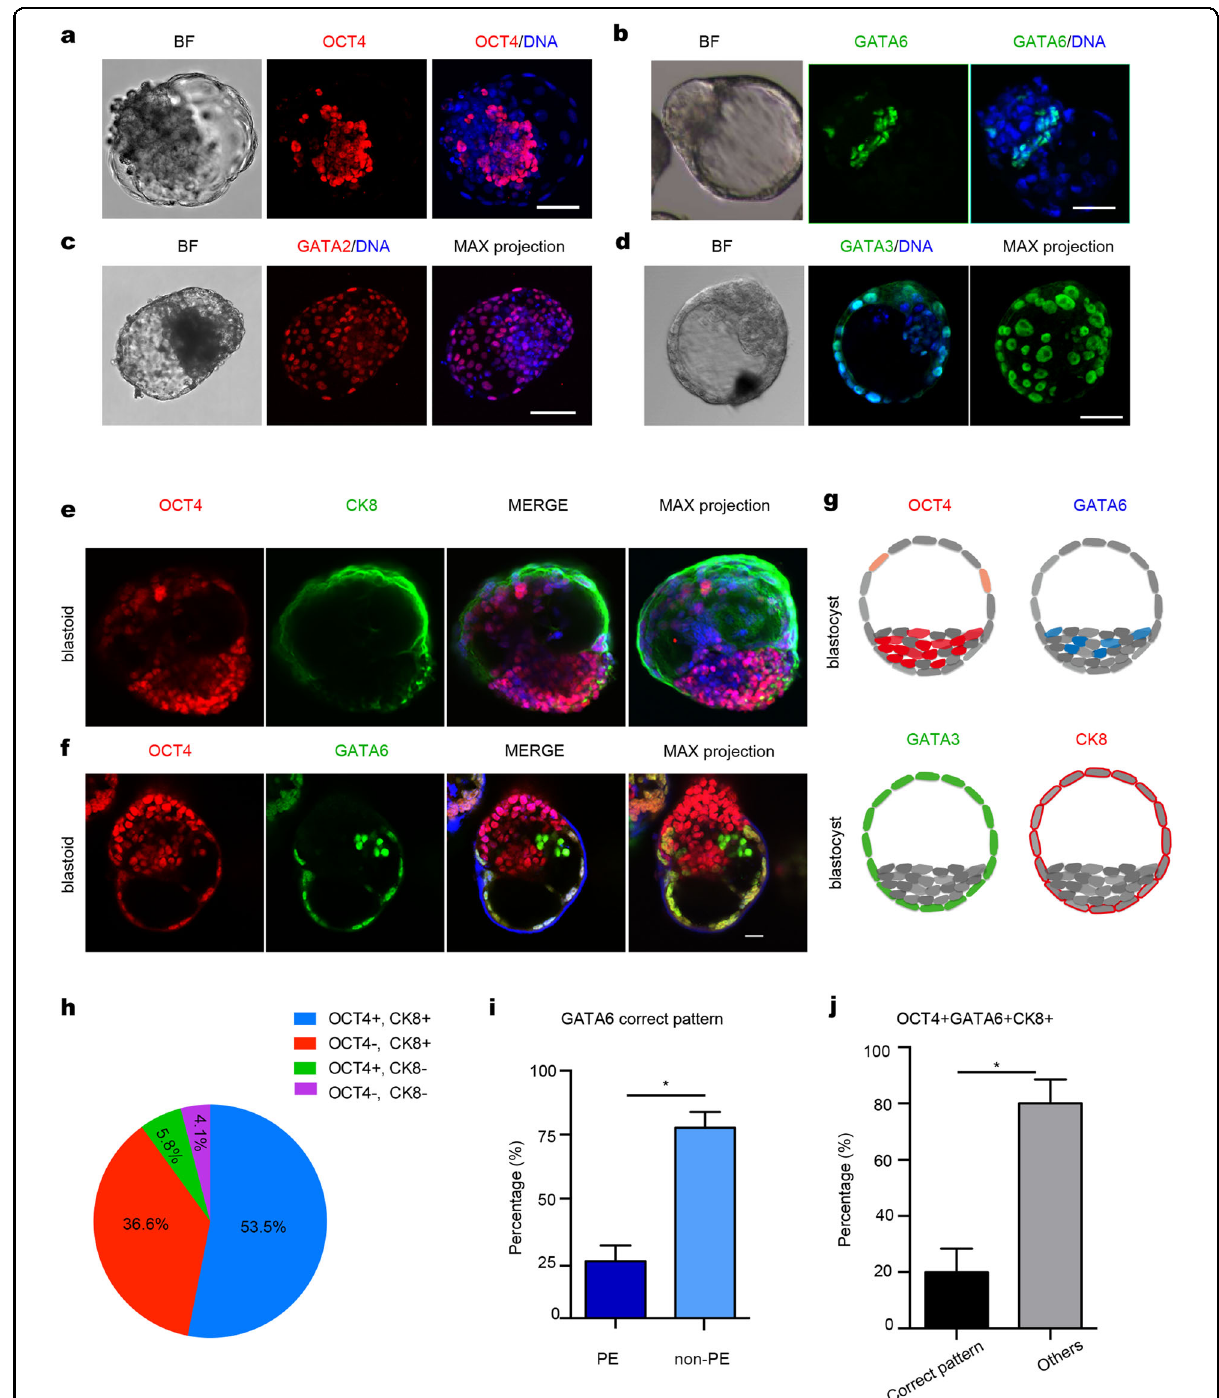
Fig. 2 Expression of speci fi c development-related markers. a – f Immuno fl uorescence staining of human EPS-blastoids for EPI lineage marker (OCT4), TE lineage markers (CK8 and GATA2/3), and PE lineage marker (GATA6), Scale bar = 50 μ m. g Model of immuno fl uorescence staining of human blastocyst for OCT4 in EPI, GATA6 in PE, GATA2/3, and CK8 in TE lineages, Scale bar = 50 μ m. h – j Quanti fi cation of the percentage of human blastoids with correct allocation of OCT4 and CK8 ( h ), GATA6 ( i ), and all three markers ( j ). Data in i , data are means ± SD ( n = 172 blastoids). * P < 0.05. Data in i , j , data are means ± SD ( n = 131